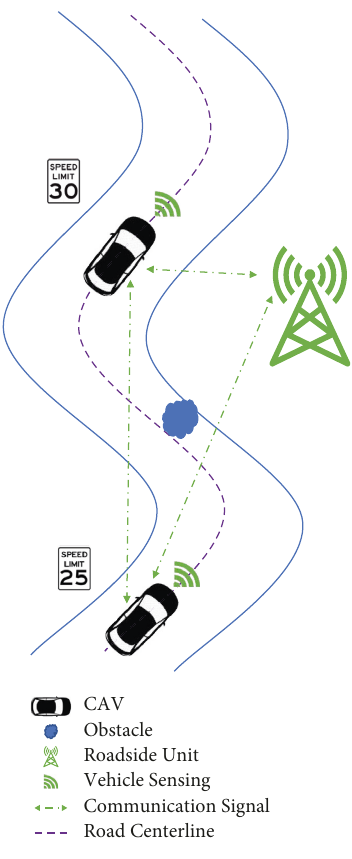
Figure 1: Problem